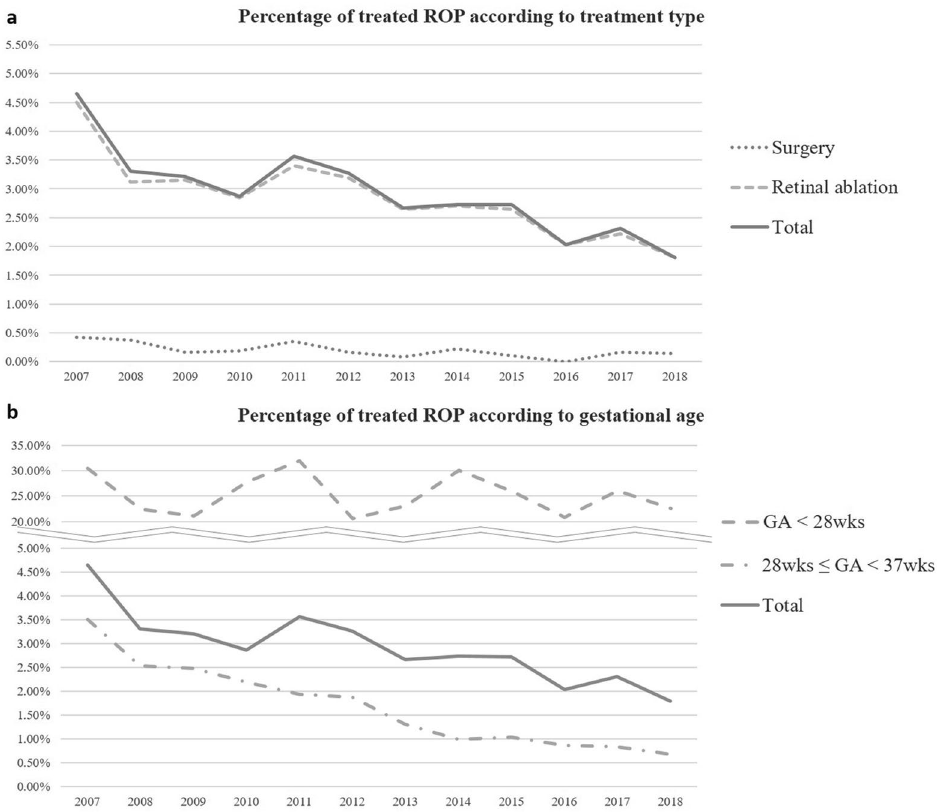
Figure 3. Twelve-year trend of treatment in retinopathy of prematurity (ROP) according to the treatment type and gestational age (GA) groups. The annual percentage of ROP infants who underwent treatment according to the treatment type ( A ) and the GA groups ( B ) are presented. GA = Gestational age; ROP = retinopathy of